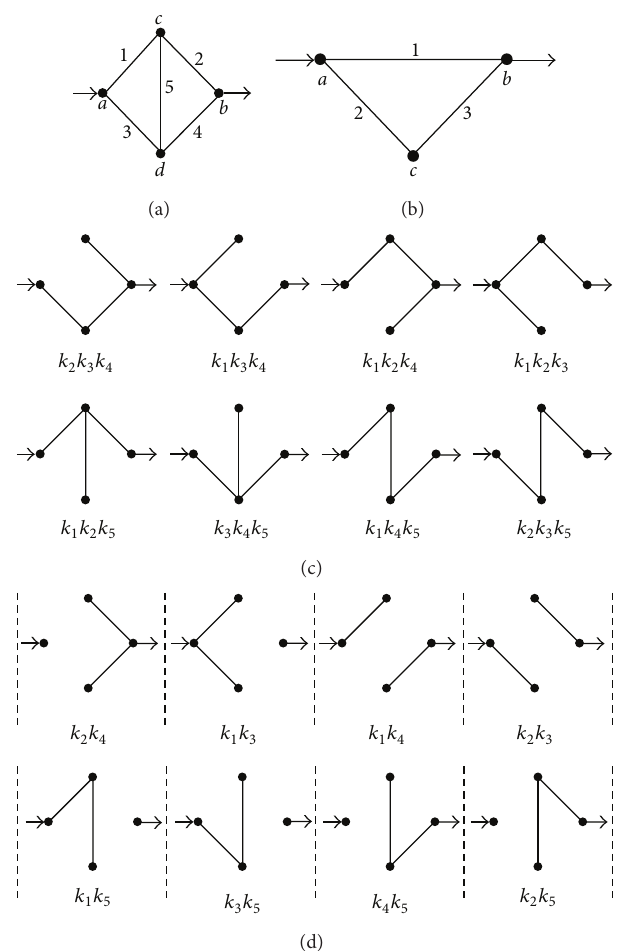
Figure 1: (a) and (b) Diagrams representing solute diffusion between positions “ 𝑎 ” and “ 𝑏 ”: a two-path model with two transi- tions each and an intermediate connection (a) and a model with two independent paths of different lengths (b). 1,2,...,5 design transitions, governed by rate constants 𝑘 1 ,𝑘 2 ,...,𝑘 5 , respectively. For each transition, the two directions are governed by the same rate constant. (c) and (d) Individual paths and their appendages (c) and directional diagrams connecting positions “ 𝑎 ” and “ 𝑏 ” (d) for the model of (a). The corresponding products of rate constants are